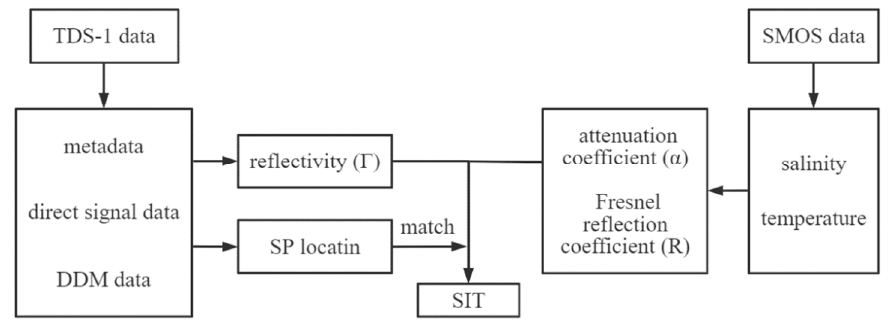
Figure 8. Flow chart of SIT calculation process. Reflectivity ( Γ ) and specular location are derived from TDS-1 data. Attenuation coefficient ( α ) and Fresnel reflection coefficient ( R ) are derived from SMOS data.